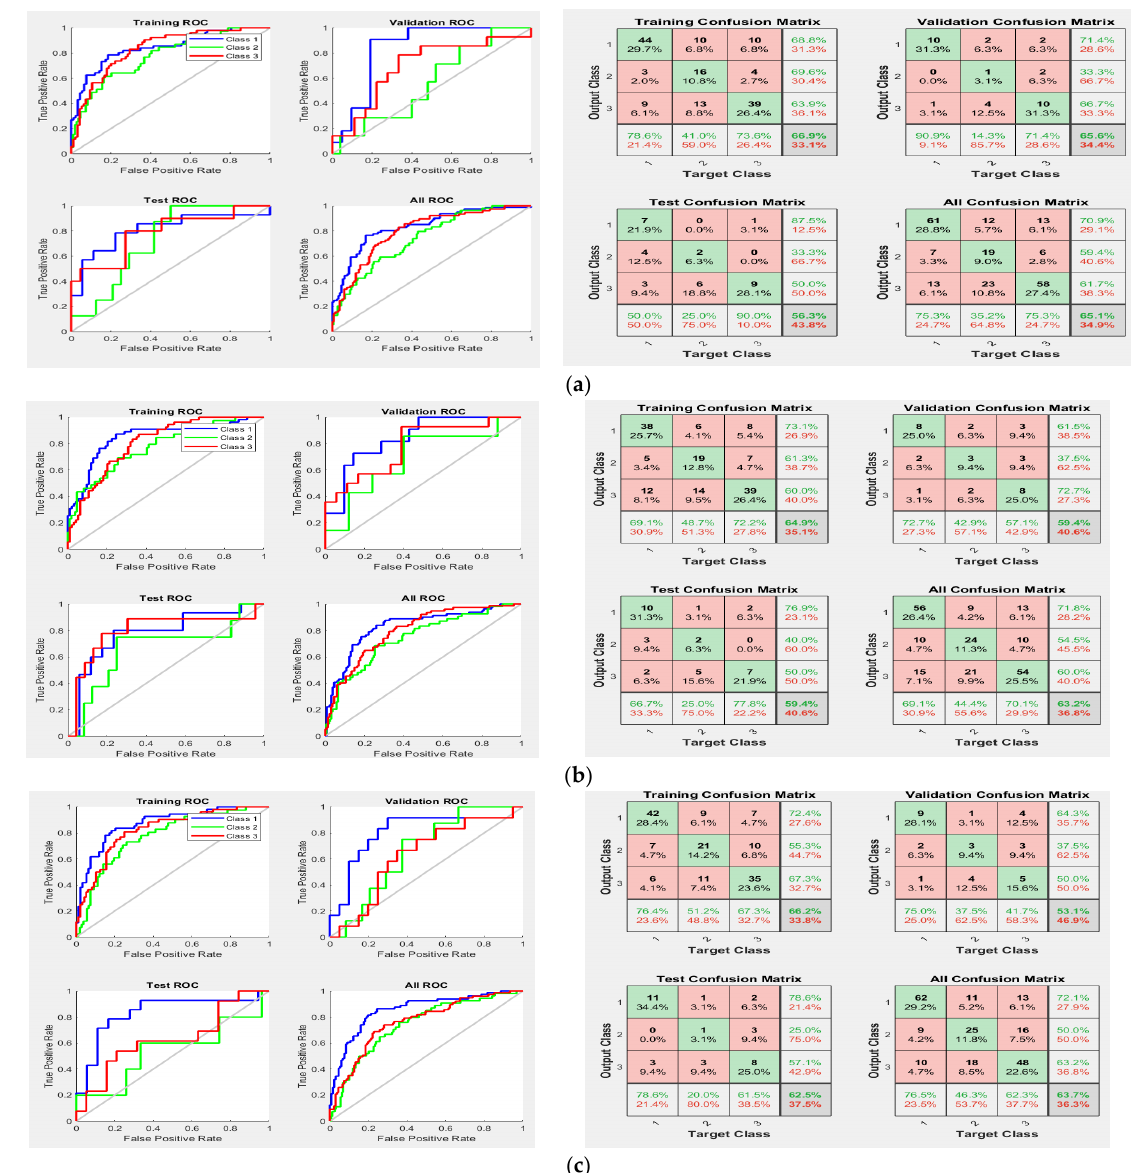
Figure 7. The receiver operating characteristic curves and confusion matrices for models in Experiment 3: ( a ) mid-sagittal approach; ( b ) mid-coronal approach; ( c ) mid-horizontal approach.